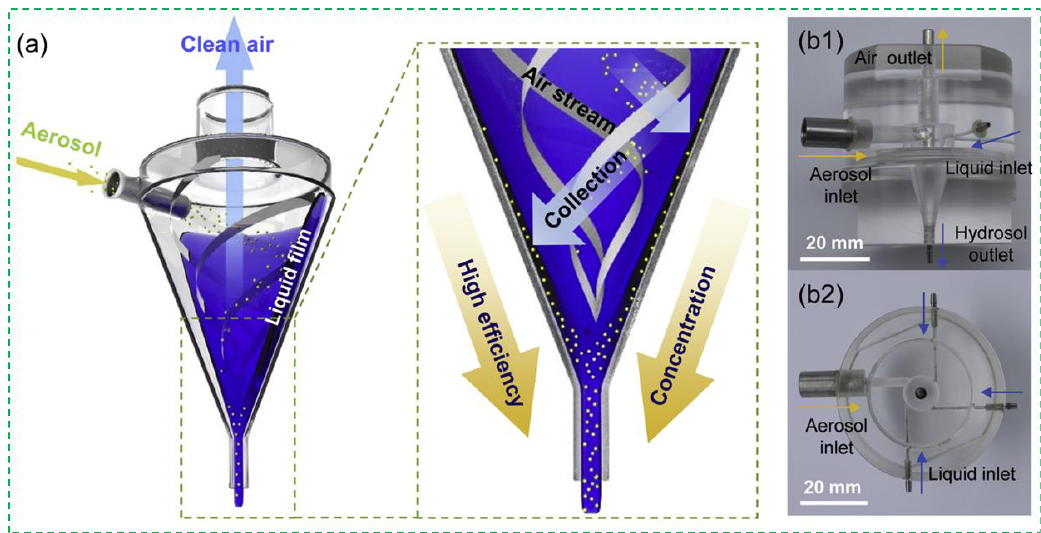
Figure 3. The centrifugation method for collection of the bioaerosols containing Staphylococcus epidermidis , Micrococcus luteus, and E. coli . ( a ) Schematic diagram of the operating principle of the wet-cyclone; ( b1 ) Front- and ( b2 ) top-view photographs of the wet-cyclone module. Reprinted with permission from ref. [46]. Copyright 2019 Elsevier B.V.